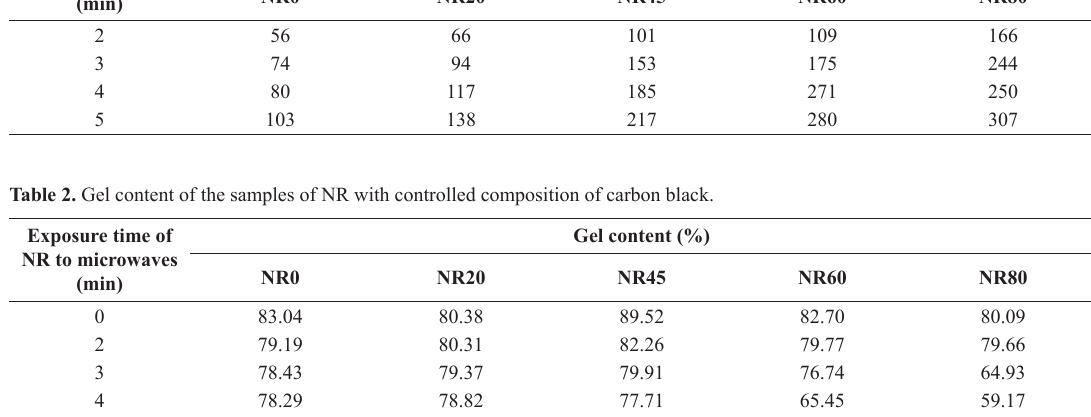
Table 1. Temperatures of the samples immediately after the microwaves treatment. Exposure time of NR to microwaves